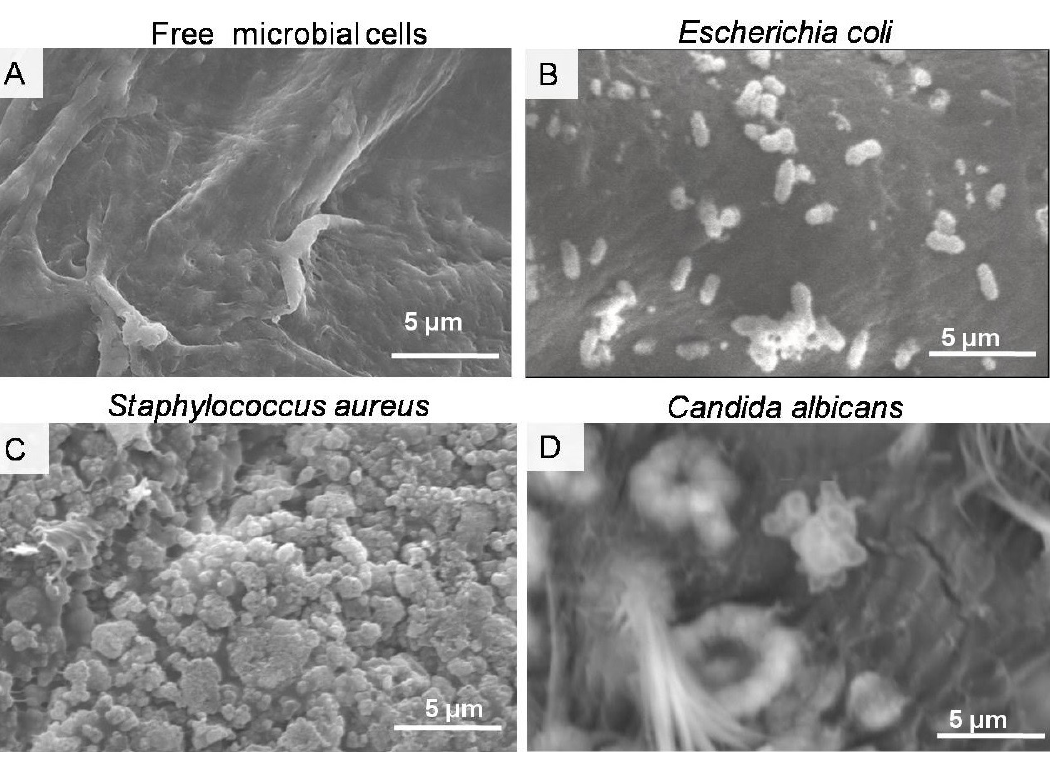
Figure 5. Evaluation of sterilization on irradiated PVA matrices. (1) non-sterile and sterile matrices with different doses of gamma radiation (2) 2 kGy, (3) 10 kGy, (4) 15 kGy and (5) 20 kGy.